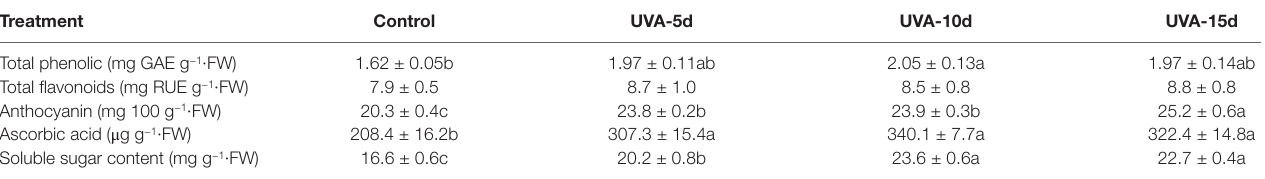
Data represent mean ± SE (n = 8). Means followed by different letters within one row differ significantly (P < 0.05) as established by the least significant difference test.